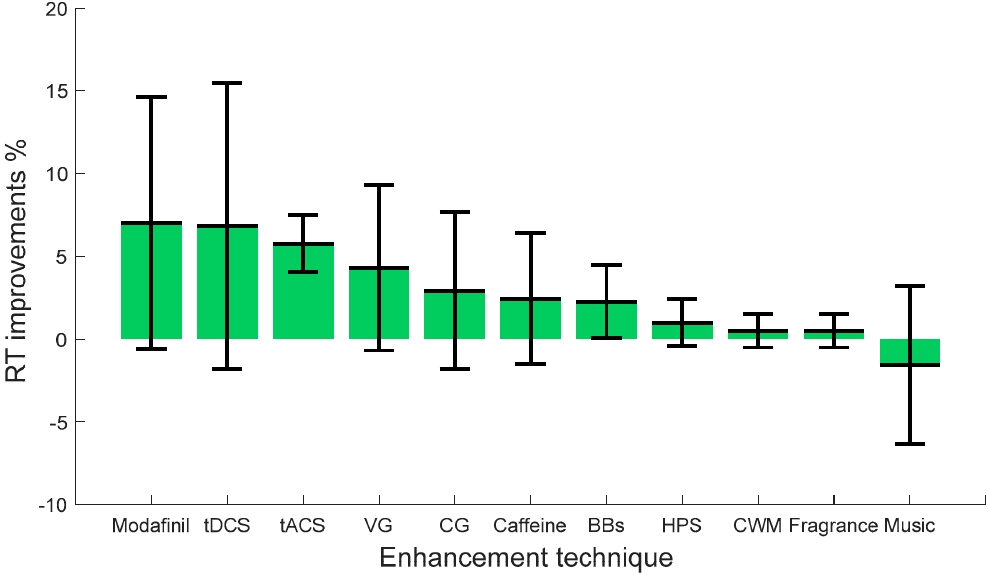
Figure 2. Percentage improvement on vigilance measured by RT when complex vigilance tasks are considered. Key to x-axis abbreviation: Transcranial direct current stimulation: tDCS; tACS: transcranial alternating current stimulation; VG: video game playing; CG: chewing gum; BBs: binaural beat stimulation; HPS: haptic stimulation; CWM: cognitive workload modulation. The error bar represents the standard deviation in reaction time (RT) improvements across different studies.